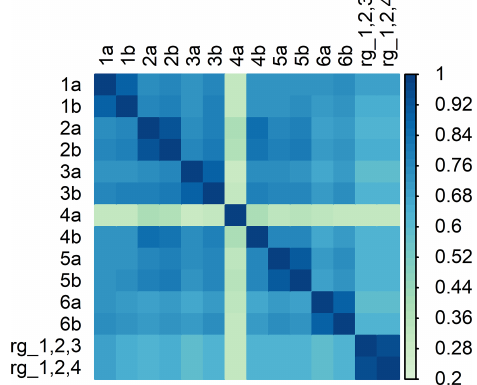
Figure A1. Statistical relationship between dry–wet classifiers based on single CML sublinks and rain gauges along the path of the long CML (rg_1,2,3) and three rain gauges near five shorter CMLs (rg_1,2,4) expressed by correlation